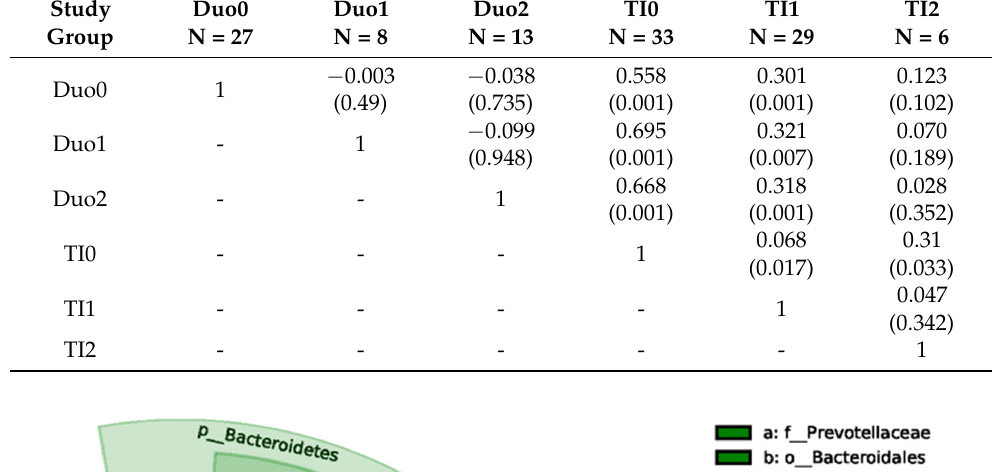
Table 2. Comparison of similarity in overall bacterial composition in the duodenum (Duo) and terminal ilium (TI) across all study groups (ANOSIM analysis). Duo0 & TI0-Controls, Duo1 & TI1- Active CD at the indicated location in the intestinal tract, Duo2 & TI2-CD without active inflammation at the indicated location in the intestinal tract. Data presented as a ratio between within-group and between-group dissimilarities; R-values and p -values (in parentheses). An R-value close to 1.0 suggests dissimilarity between groups, while an R-value close to 0 suggests an even distribution of high and low ranks of dissimilarities within and between groups. R-values below 0 suggest that dissimilarities are greater within groups than between groups [12].